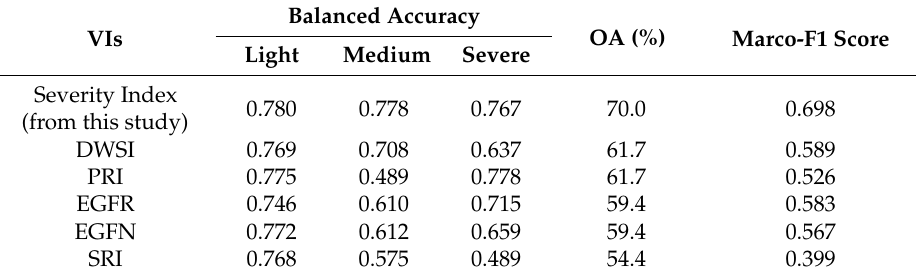
Table 5. Validation results of the SCR severity model using the support vector machine-based 10-fold cross